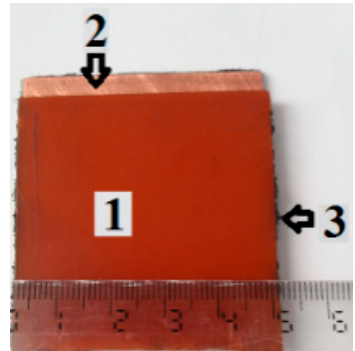
Figure 6. Flat capacitor: 1—TCu plate; 2—copper-plated side of the TCu; 3—hMRE.